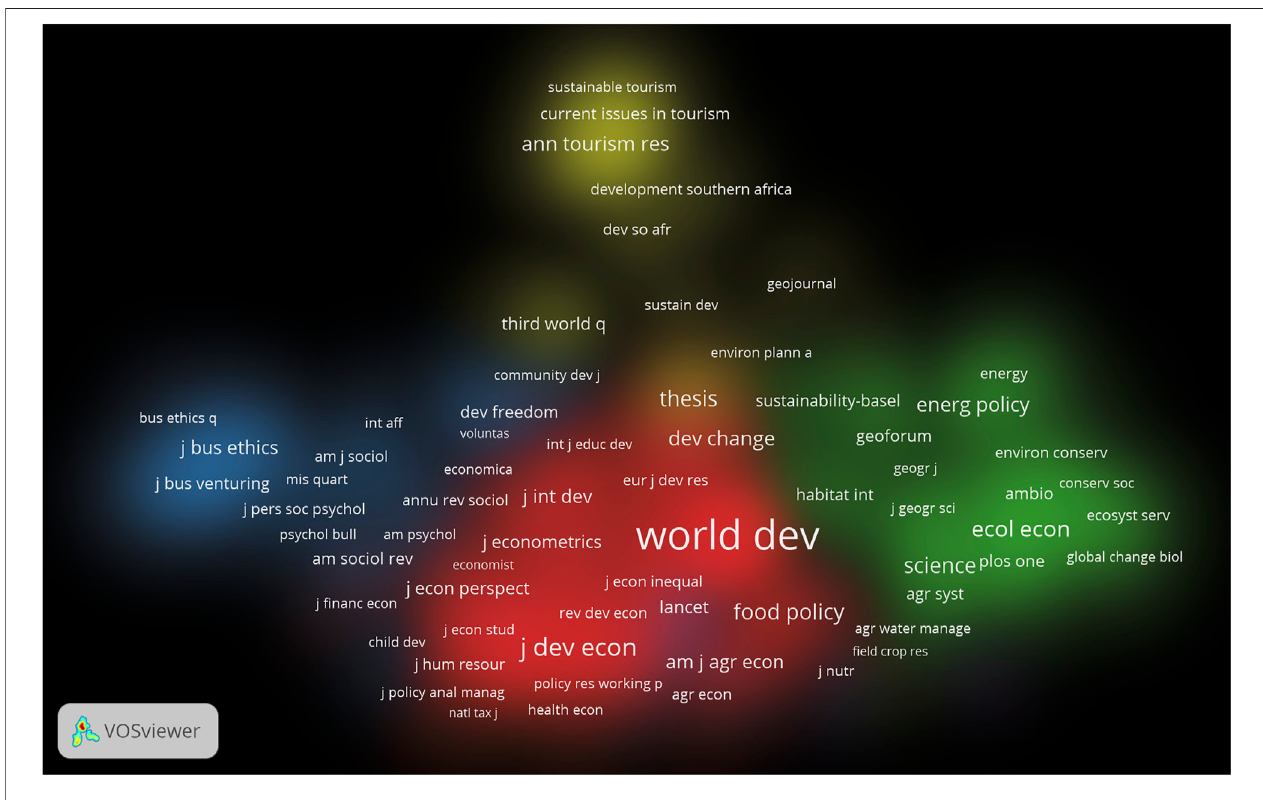
FIGURE 7 | Cited source density network of